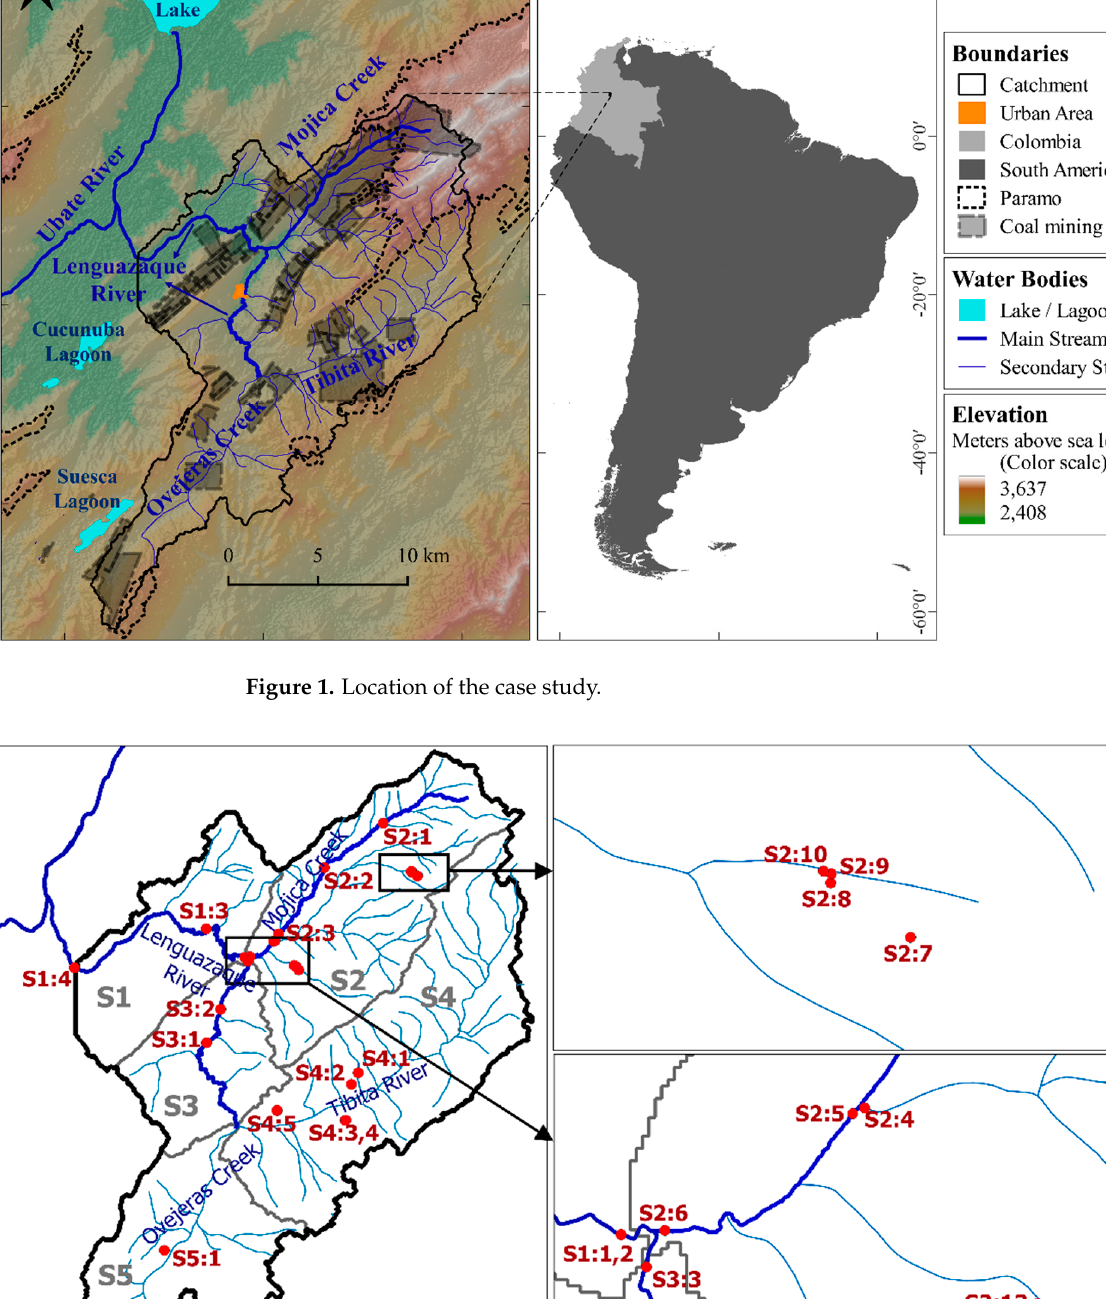
Figure 2. Location of sub-basins and monitoring sites.